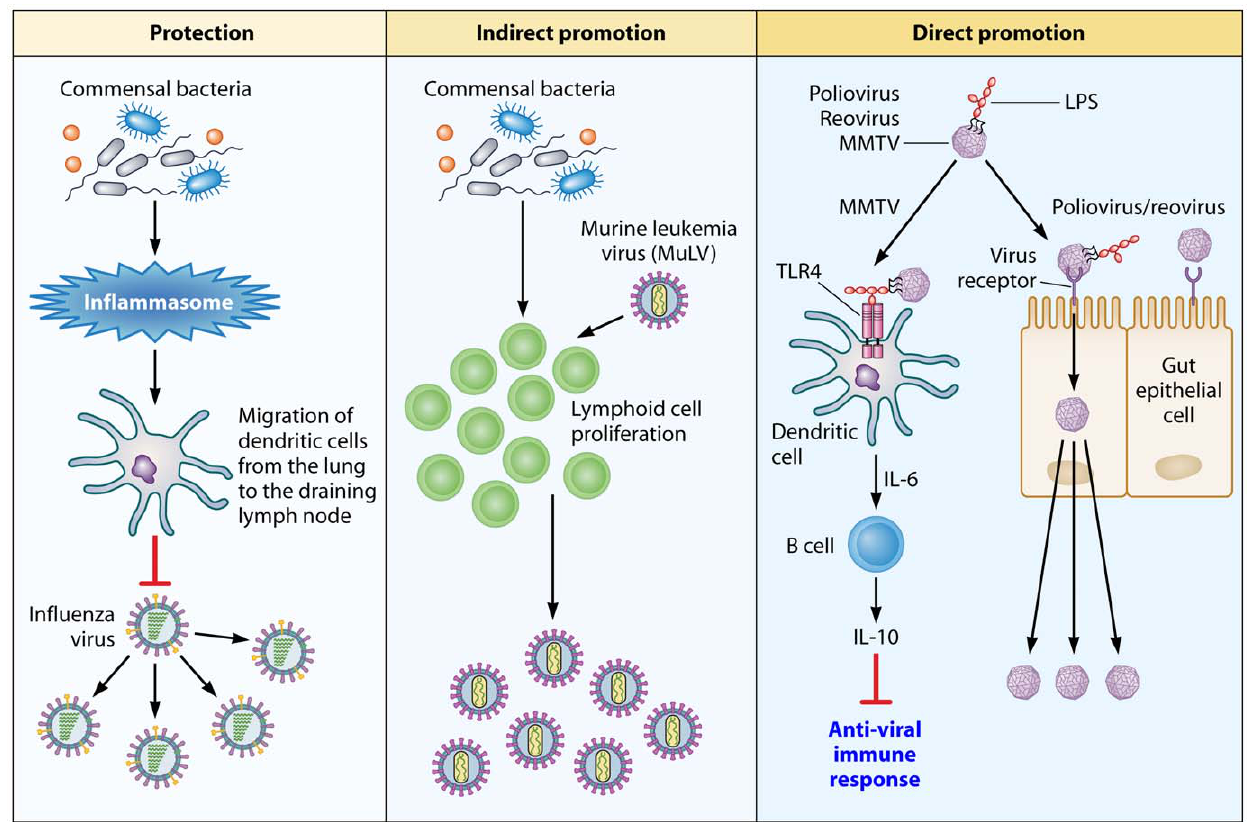
Figure 1. An overview of how the commensal microbiota influence viral pathogenesis. Protection: The microbiota of the host activates the inflammasome by priming signal 1 for IL-1 b and IL-18 secretion. The secretion of these cytokines induces migration of dendritic cells from the lung to the draining lymph node, where they prime T cells. The downstream effect of T-cell priming is protection of the host against influenza virus- induced pathology. Indirect promotion: In the case of MuLV, the microbiota of the host stimulate proliferation of lymphoid cells that are targeted by the virus. Direct promotion: Microbial ligands, such as LPS, are utilized by viruses to enhance their attachment to target cells (polio virus and reovirus) or to counteract the antivirus immune response by activating the TLR4 pathway, which leads to IL-10 production